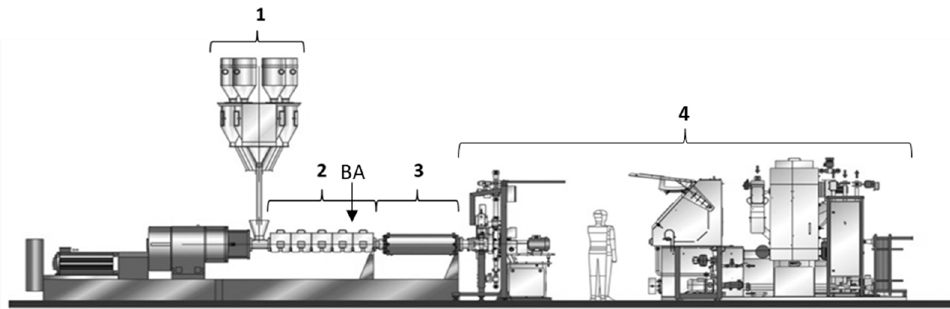
Figure 1. Sketch of the Sulzer extruder based ePP process as used in the trial (the person is depicted to give a size reference).